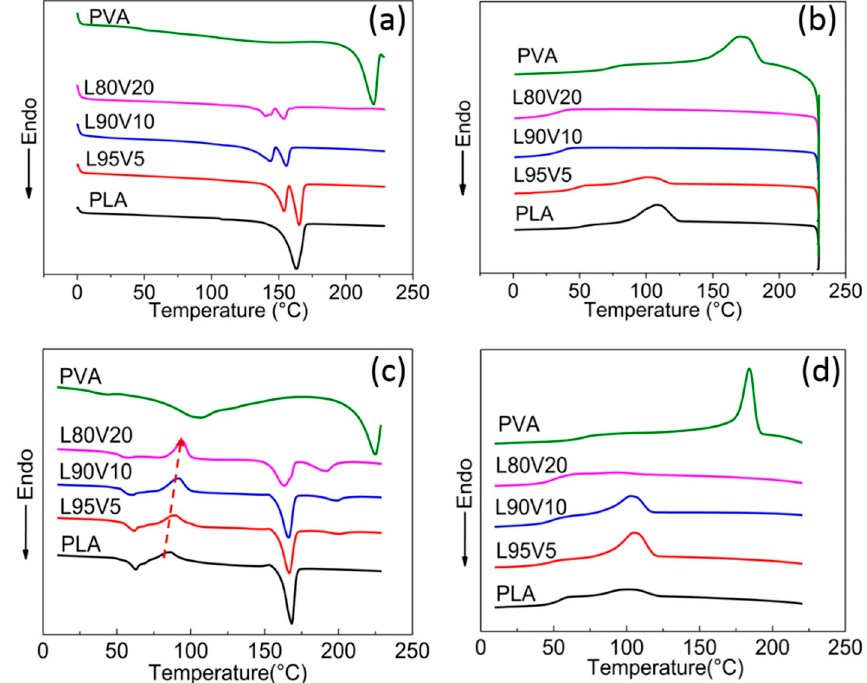
Figure 2. The heating ( a ) and cooling ( b ) differential scanning calorimetry (DSC) curves of the casting film. The first heating ( c ) and cooling ( d ) DSC curves of the PLA fiber membrane with varying content of PVA.